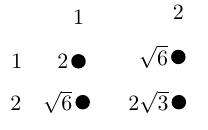
Figure 2 . Lattice for a system with n = 6 , u 0 = 1 / 2 , u 1 = 1 , u 2 = 3 / 2